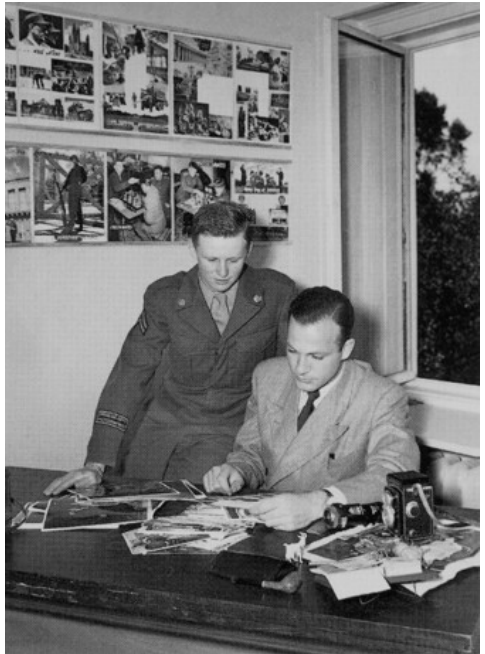
Figure 7. Henry Ries in the editorial team (with Clayton Hemsey) of the OMGUS Observer , vol. 53 (26 July 1946). Photograph. © Henry Ries. Deutsches Historisches Museum. Invoice No. 2007/4176.251, file PH009620.